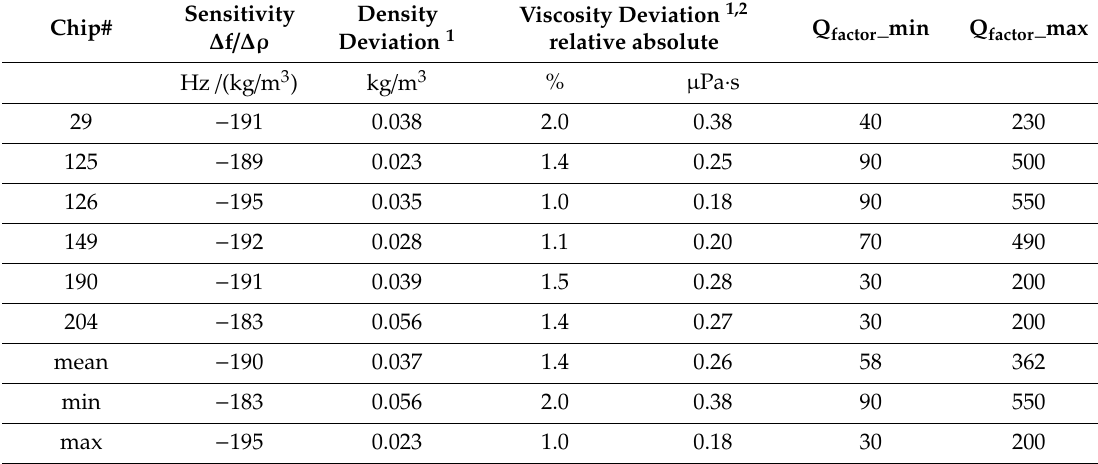
Table 3. Density and viscosity measuring performance of bare cantilevers after calibration with N 2 , CO 2 , Ar and He at temperatures between 0 and 60 °C and pressures between 1 and 10 bar.